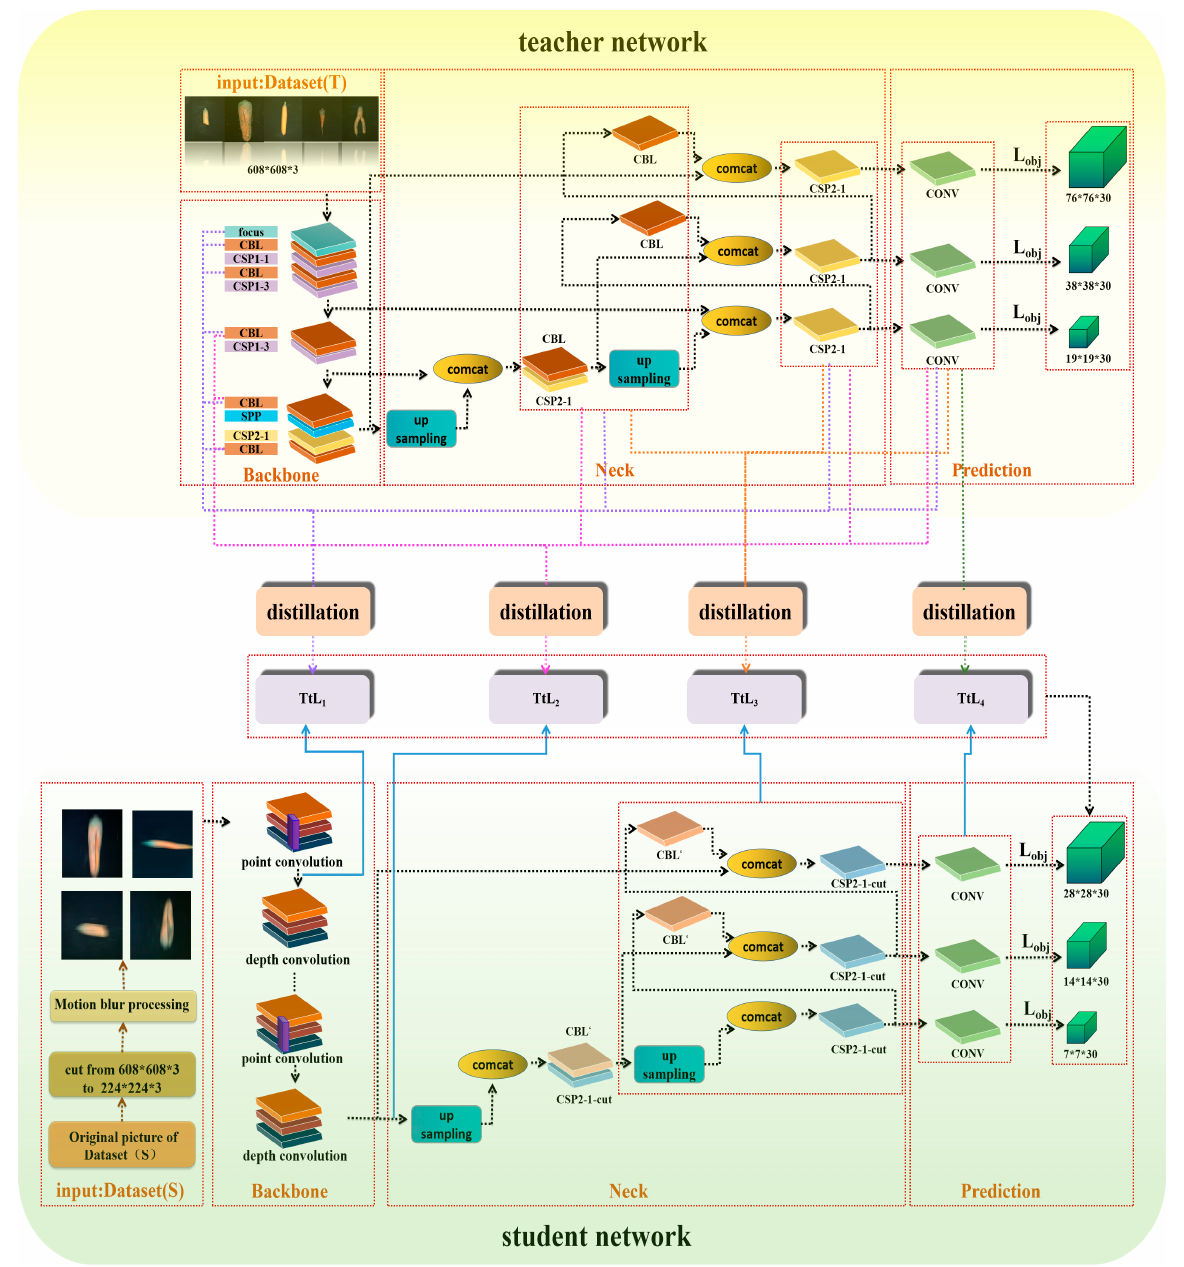
Figure 4. The main structure of the knowledge distillation training student network proposed in this